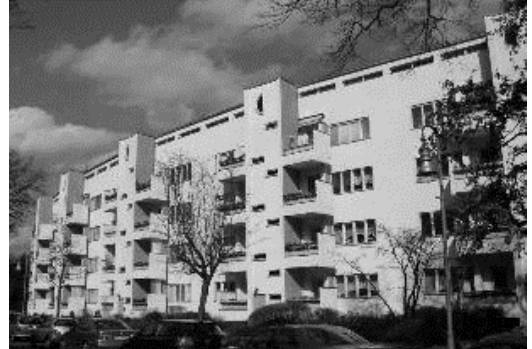
Figure 4. Großsiedlung Siemensstadt 1929 Gropius. (Pevsner,